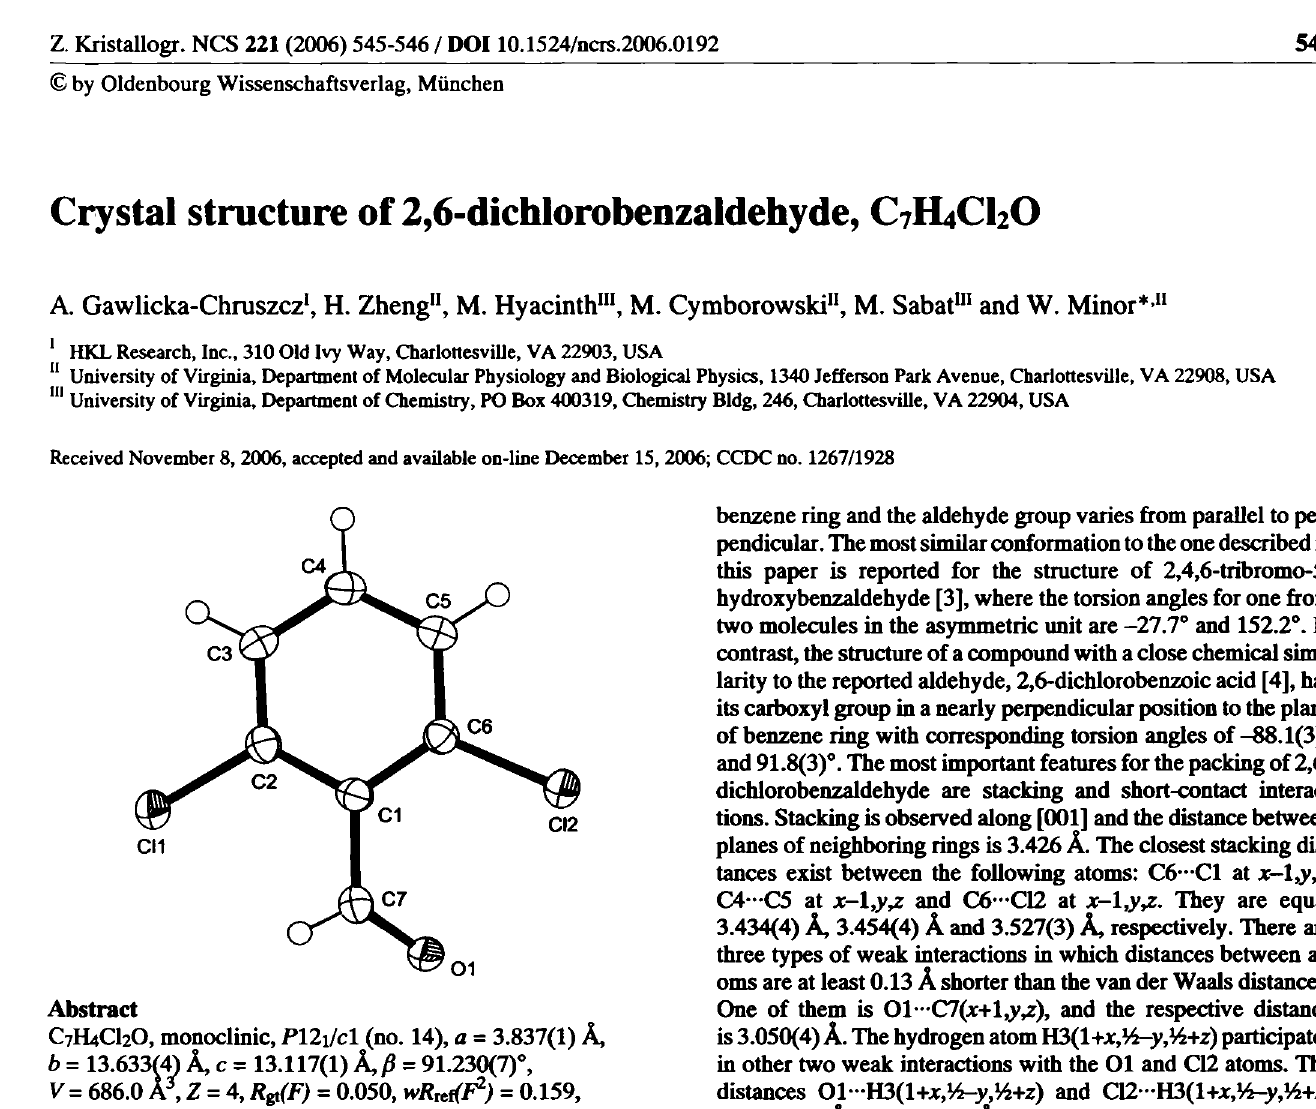
Table 1. Data collection and handling.